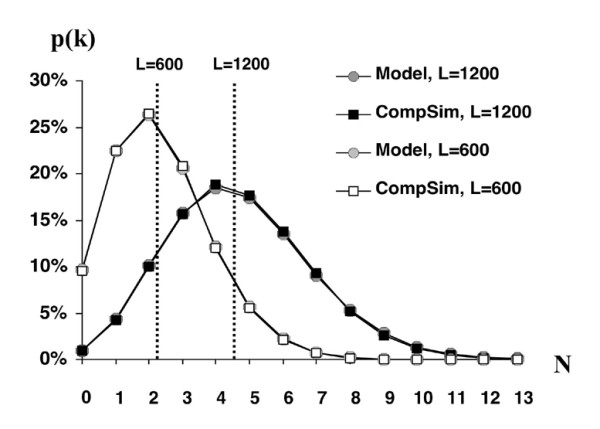
Probability (p(k)) to find k AERS(CATG) in a random sequence for L = 600 and L = 1200 bp. Dotted lines represent p(k) mean values. L, sequence length; Model, mathematical modeling; CompSim, computer simulation (1,000,000 simulations).